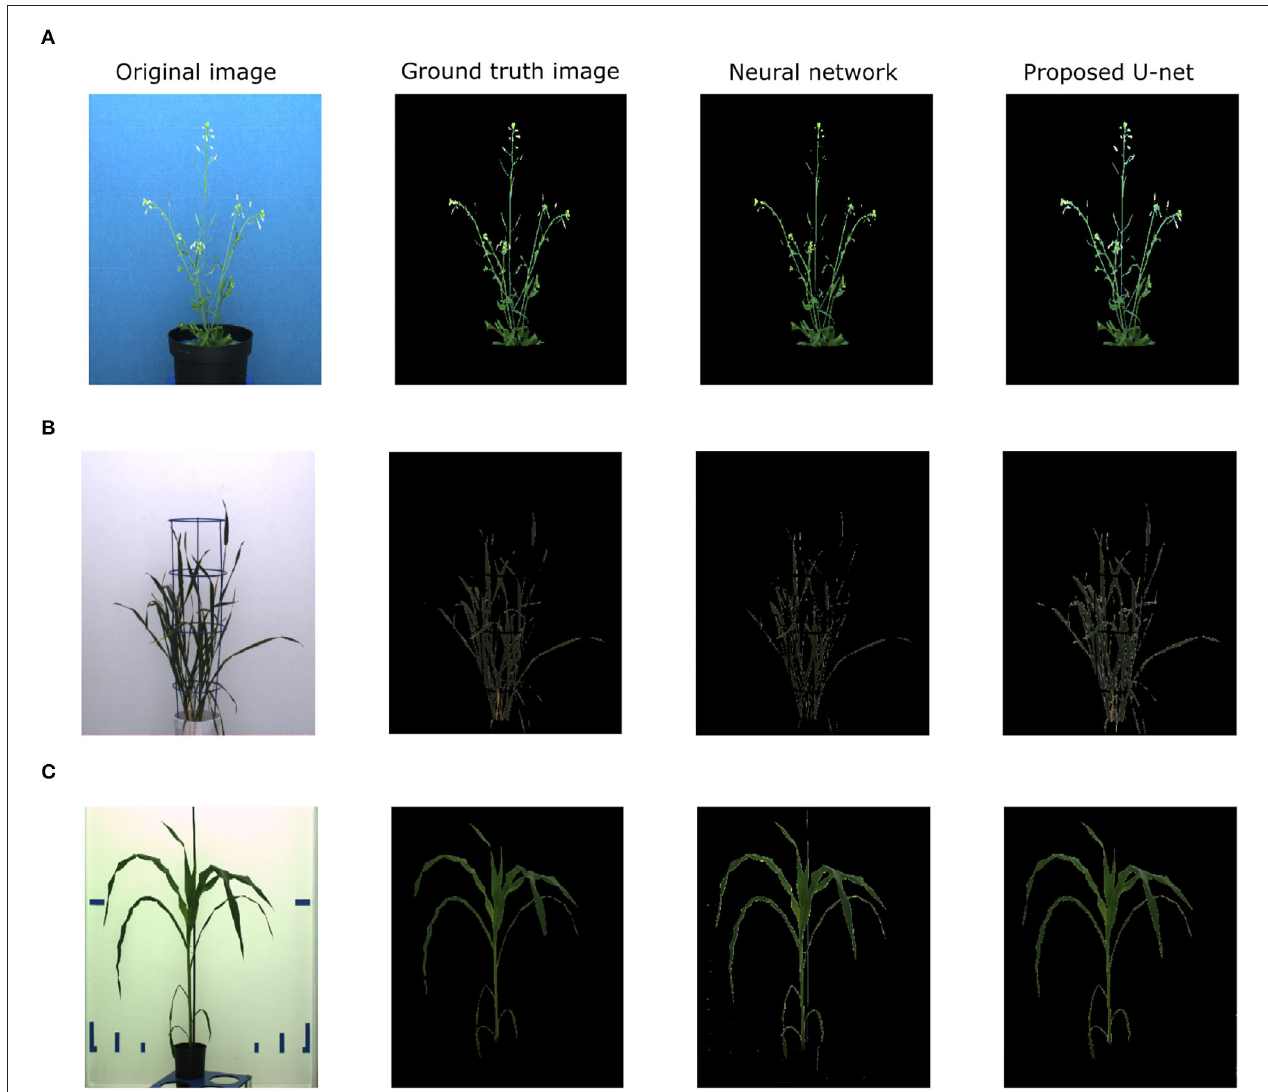
FIGURE 10 | Evaluation of neural network segmentation with respect to the proposed U-net on arabidopsis, barley and maize side view images respectively. (A) NN DC: 0.7824, DeepShoot DC: 0.8342, (B) NN DC: 0.6973, DeepShoot DC: 0.8924, (C) NN DC: 0.8746, DeepShoot DC: